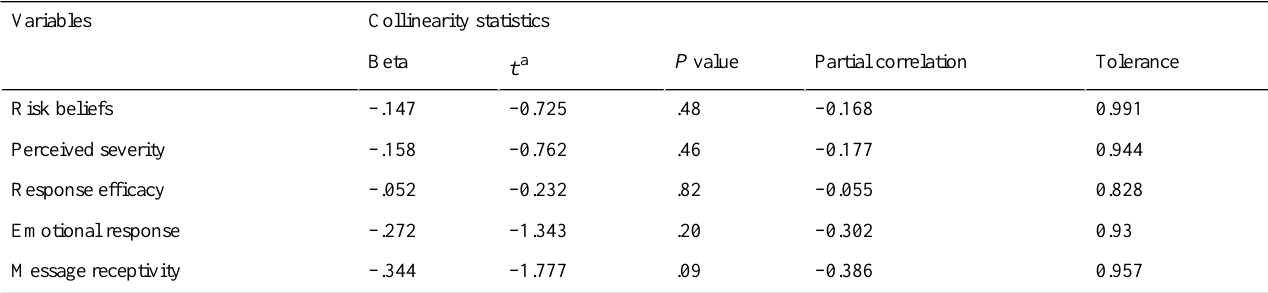
Table 4. Excluded variables in stepwise procedure.